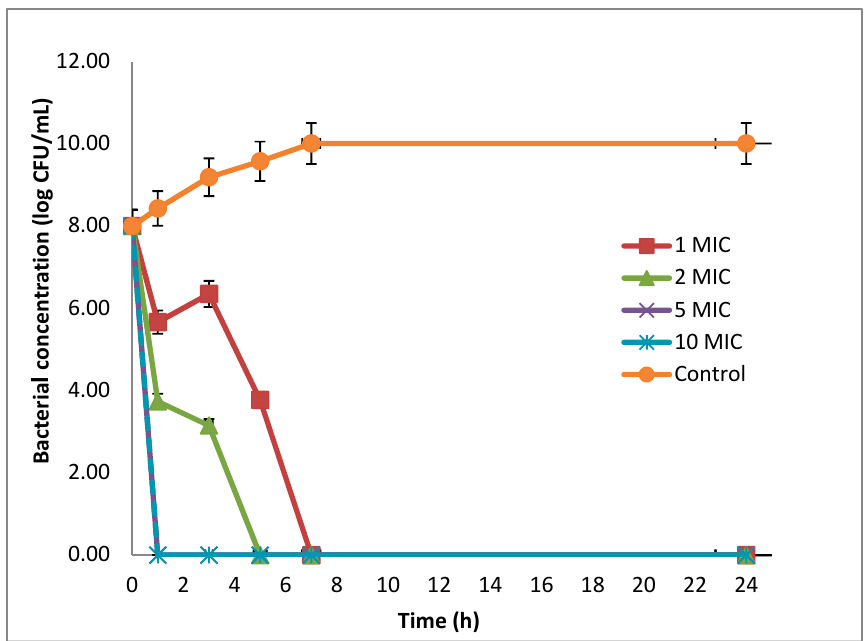
Figure 3. Time–kill kinetics of the L. cubeba fruit EO on the viability of E. coli ATCC 25922 (n = 3 ± SD). The bacterial cells were treated with different concentrations of EO (1, 2, 5, and 10 MIC) for 24 h. The control was EO-untreated cells.